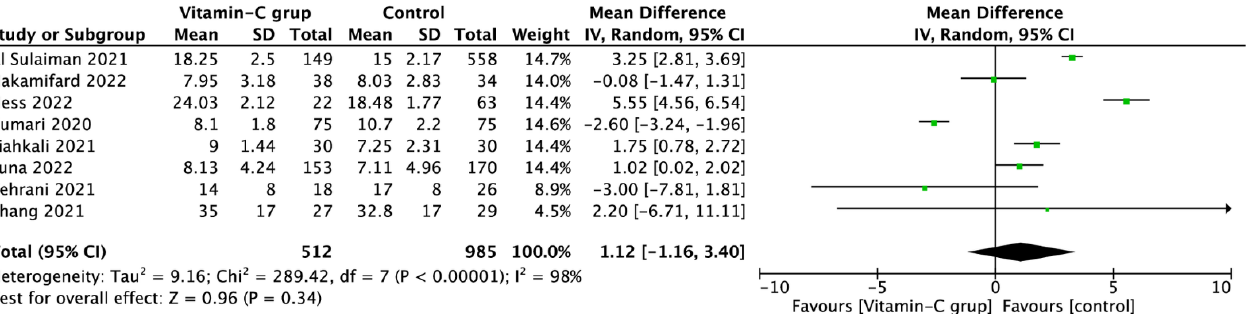
Figure 5. Forest plot of hospital length of stay among COVID-19 patients with and without vitamin C supplementation. The center of each square represents the mean differences for individual trials, and the corresponding horizontal line stands for a 95% confidence interval. The diamonds represent pooled results [32,38–40,43,45,46,48]. Table 2. Pooled analysis of adverse